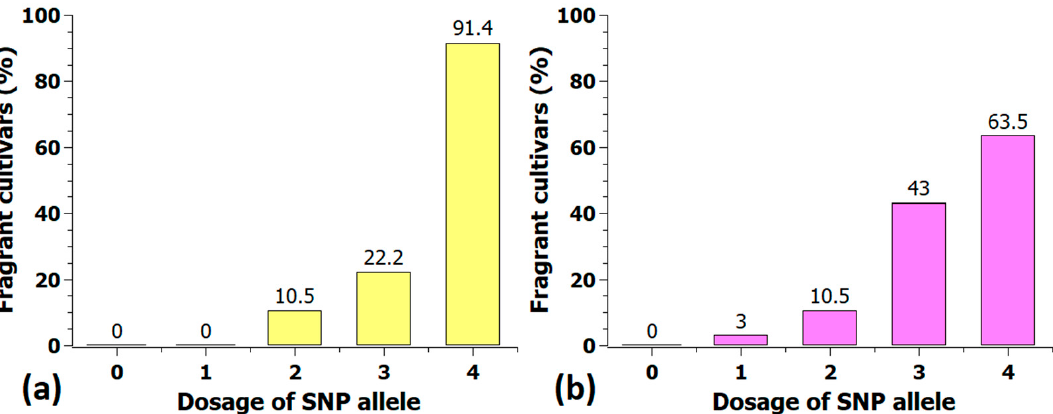
Figure 10. Percentage of fragrant cultivars (fragrance score ≥ 2) in the five marker classes of the KASP-marker Rh_FR_SNP139K in the association panel ( a ) and in the validation population with 222 cultivars ( b ). Shown above the columns are the percentages of fragrant cultivars.